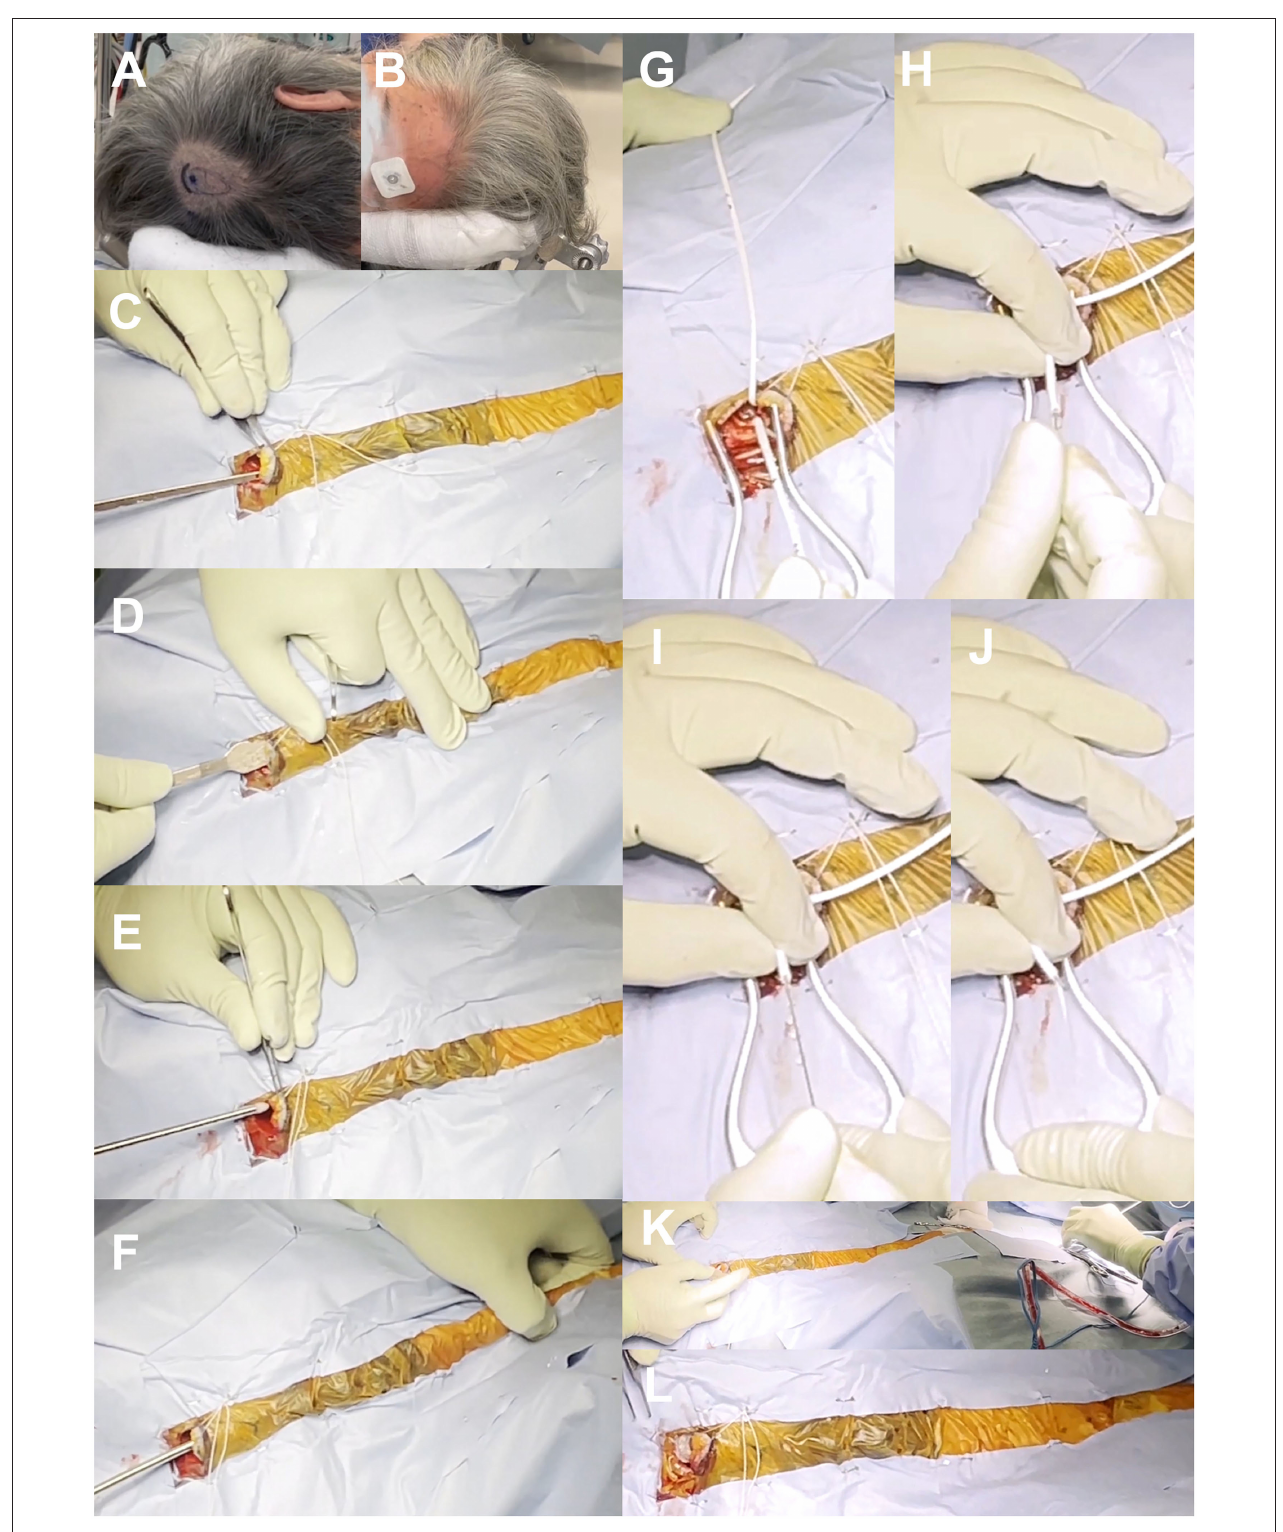
FIGURE 4 | Surgical photographs. Marking of skin incision and valve placement position (A) , putting electrocardiogram sticker on the target point of scalp (B) , subcutaneous tunnel using spatula-shaped passer (C,D) and long cylindrical passer (E,F) , insertion of ventricular catheter (G–J) , and placement of shunt valve (K,L) .